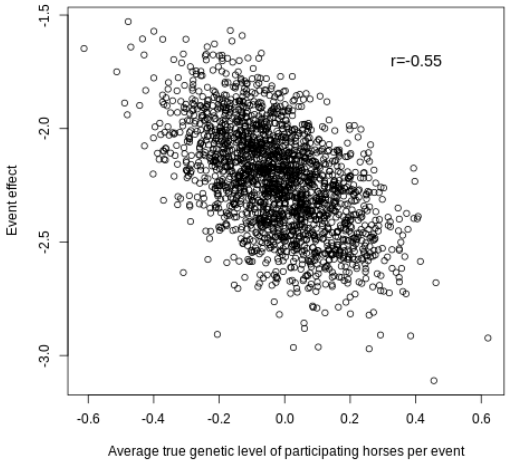
Figure 4. Two-dimensional plot of the estimate of the event effects and the average true genetic level for the liability of the ranking trait of the horses competing in an event.